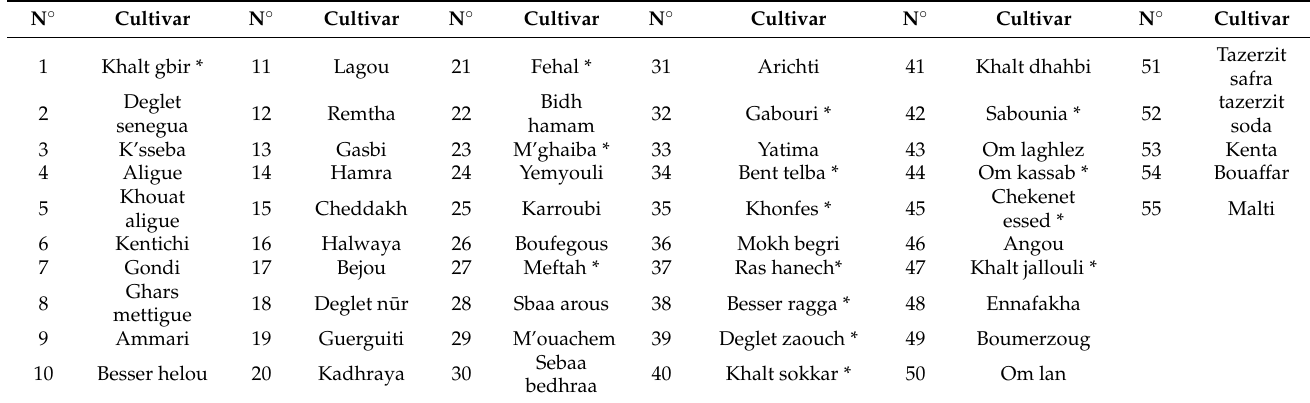
Table 2. Date palm cultivars present in the El Hamma oasis in 2003: 40 ecotypes are present throughout the region, while 15 (indicated with * in the table) are specific to the oasis of El Hamma. (Modified from Rhouma et al. 2003 [47]). N ◦ Cultivar N